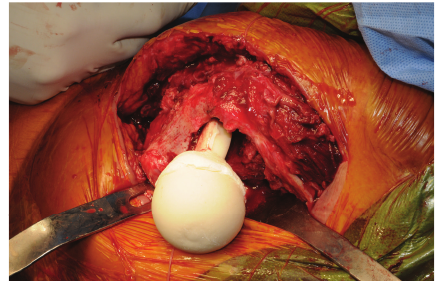
Figure 1: In the second operation, we removed the prosthesis, performed the irrigation, and inserted the cemented spacer mixed with the antibiotics for reducing the